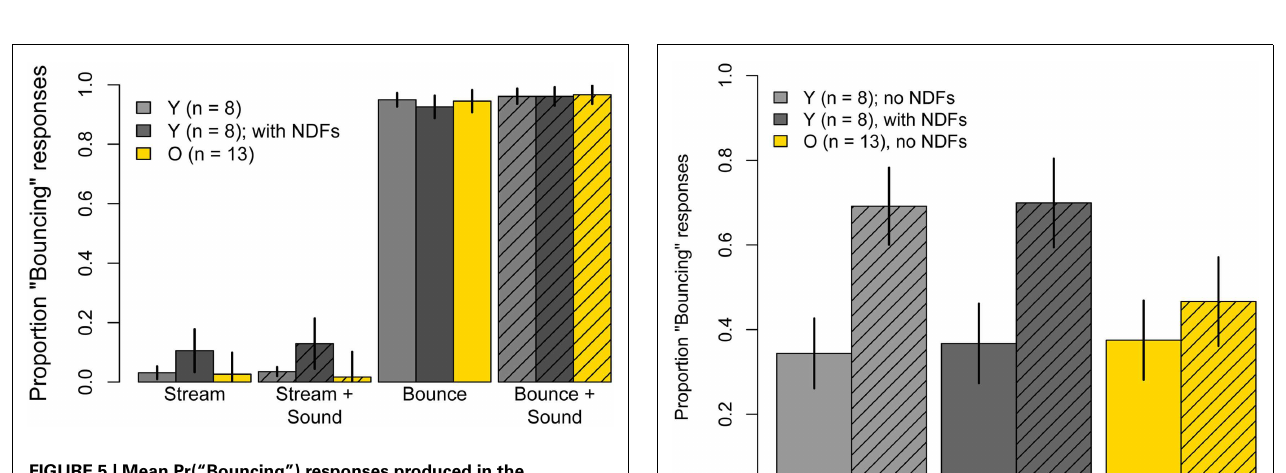
FIGURE 5 | Mean Pr(“Bouncing”) responses produced in the unambiguous conditions of Experiment One: Bouncing and Streaming motion and Bouncing and Streaming motion accompanied by the sound used in Experiment One . Light gray bars represent data for eight younger subjects when they viewed the stimuli normally, without neutral density filters, and the dark gray bars represent results obtained when subjects viewed the stimuli through three neutral density filters.Yellow bars represent data of 13 older subjects who participated in Experiment One and were tested again in these conditions without neutral density filters. Error bars are ± 1 standard error of the mean.